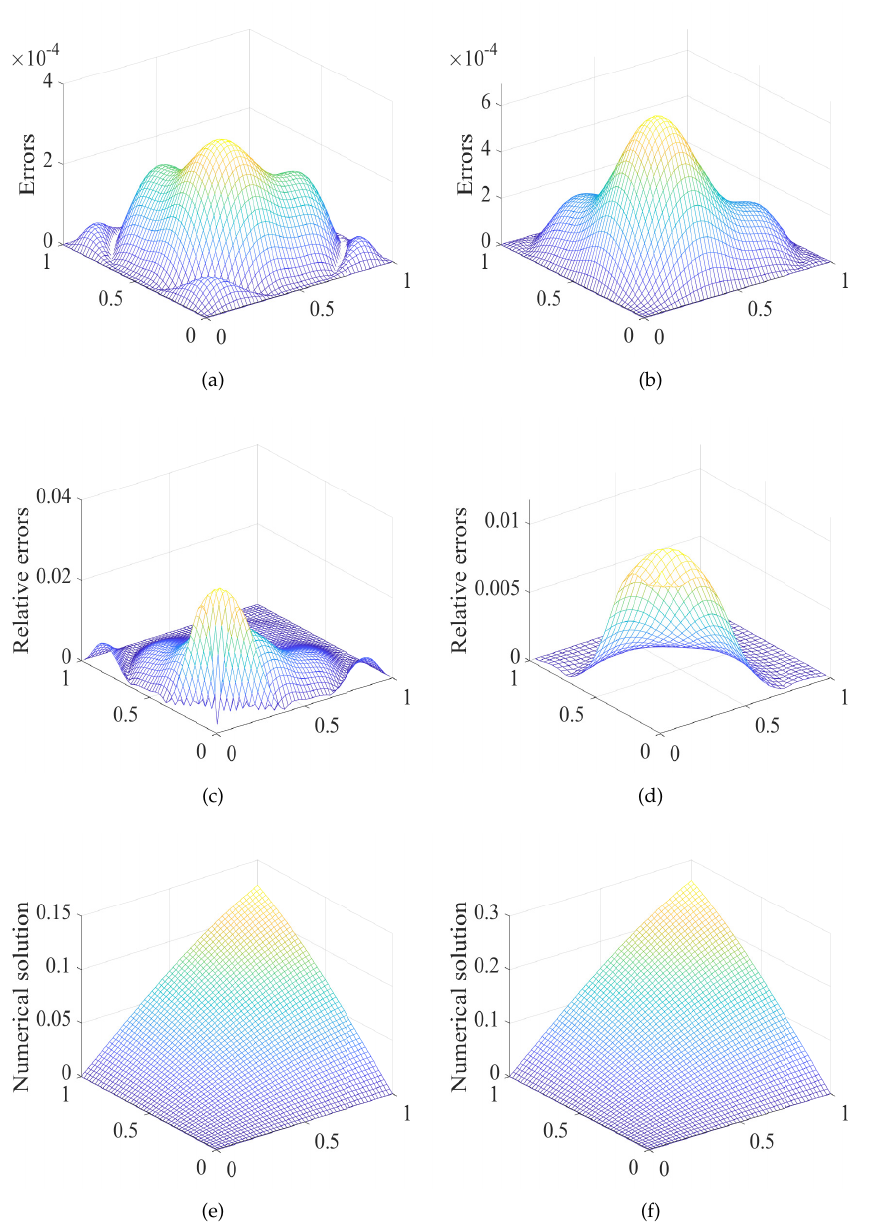
Figure 7. The errors and numerical solutions of the AAI algorithm when l = m = s = 51, h = 1/50, n = 150, ω = 1.96. ( a ) The errors at z = 1/3; ( b ) The errors at z = 2/3; ( c ) The relative errors at z = 1/3; ( d ) The relative errors at z = 2/3; ( e ) The numerical solution at z = 1/3; ( f ) The numerical solution at z =